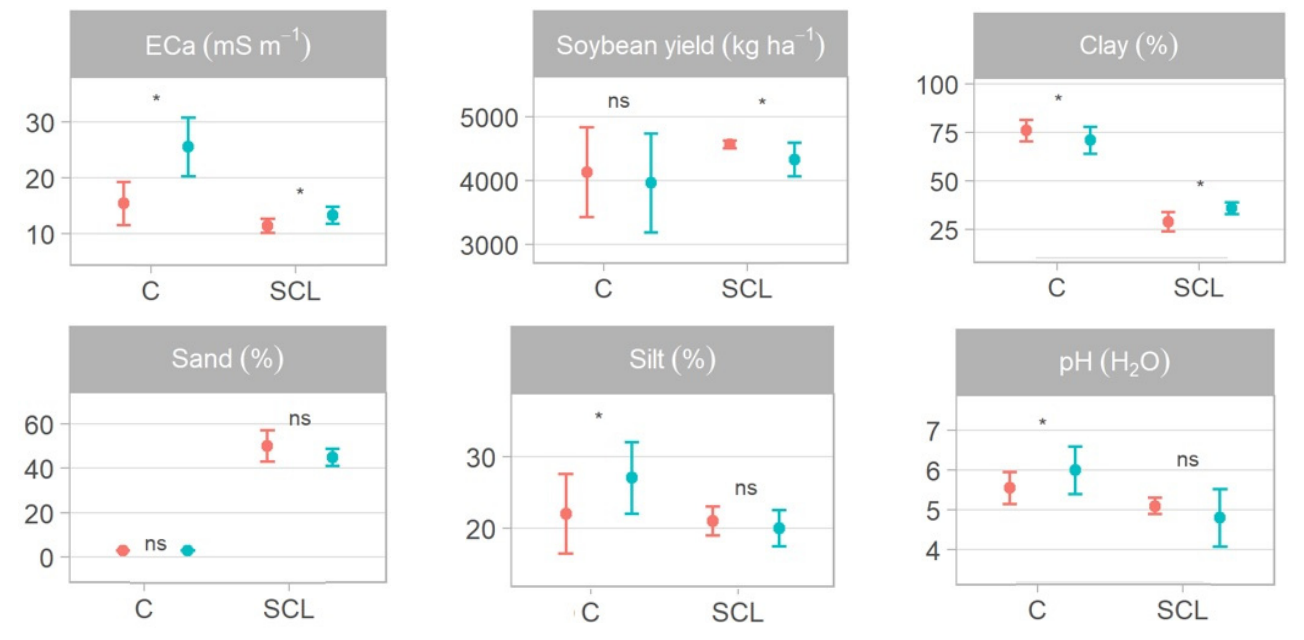
values, depending on the sampling by management zones.